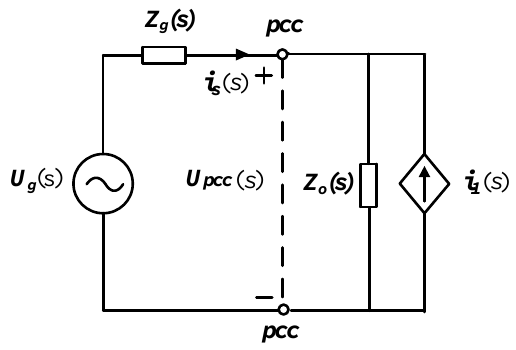
represents the grid connection current and Z g ( s ) is the grid impedance.